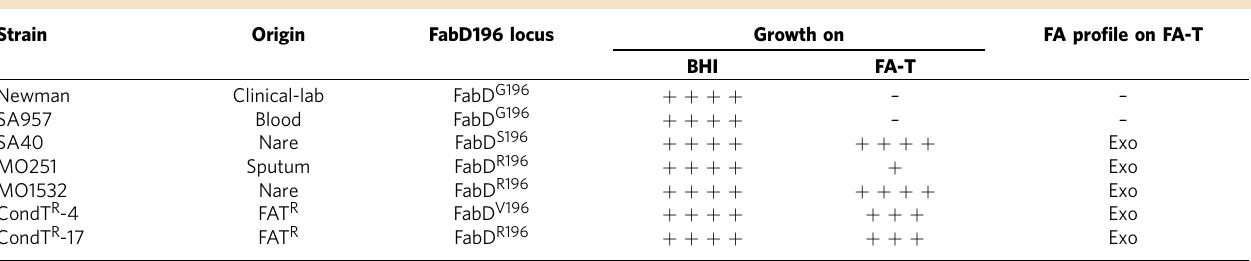
Table 2 | Natural clinical isolates bear fabD variants that favour FASII